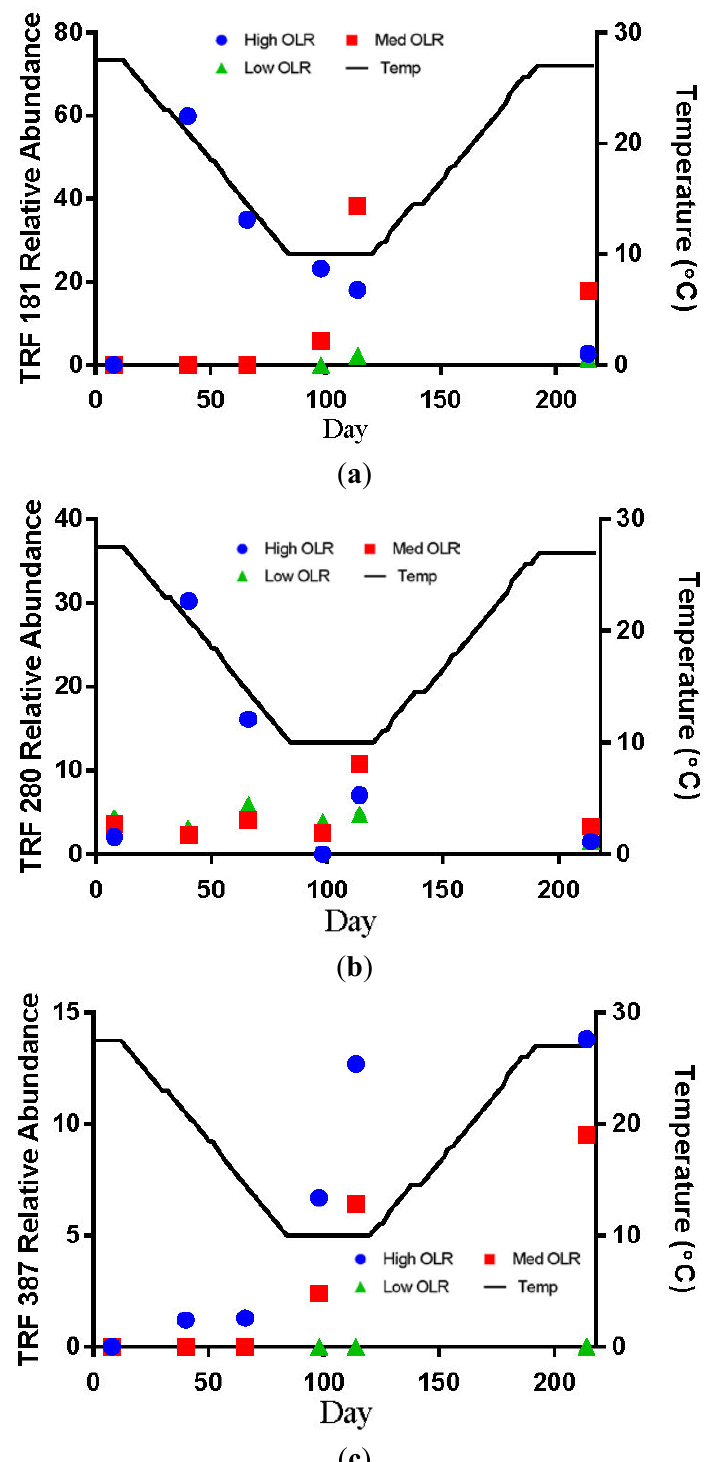
Figure 3. Scatter plots of the relative abundance of the dominant archaeal TRFs. ( a ) TRF 181 ( Methanosarcina ); ( b ) TRF 280 ( Methanosaeta ); ( c ) TRF 387 ( Methanomicrobiaceae or Methanobrevibacter sp.; ( d ) TRF 785 ( Methanobrevibacter sp.); and ( e ) TRF 791 ( Methanobrevibacter